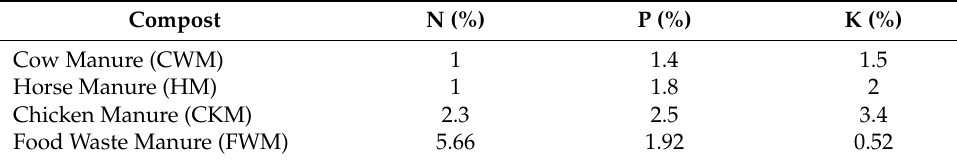
Table 1. The nutrient content in the different